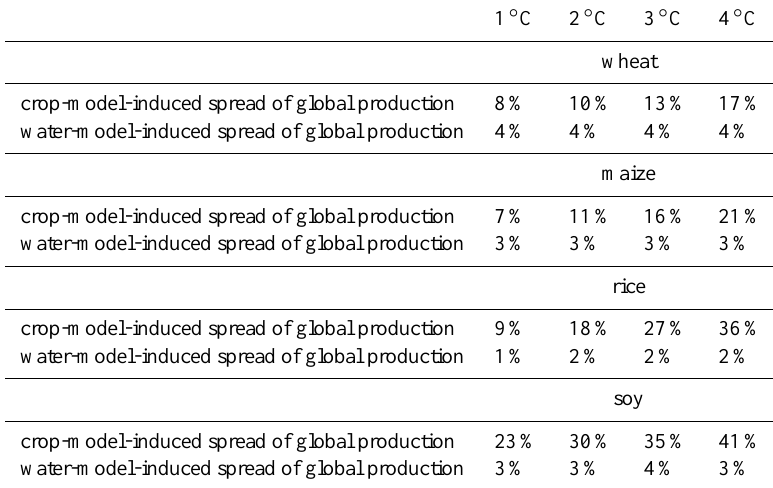
Table 5. Comparison of the crop-model-induced spread in global crop production to the water-model-induced spread at different levels of global warming in comparison to the 1980–2010 reference level. Global production is calculated based on present day LU (Portmann et al., 2010) and extended irrigation patterns according to water availability described by the water models (Sect. 3.3 and Sect. 3 in the